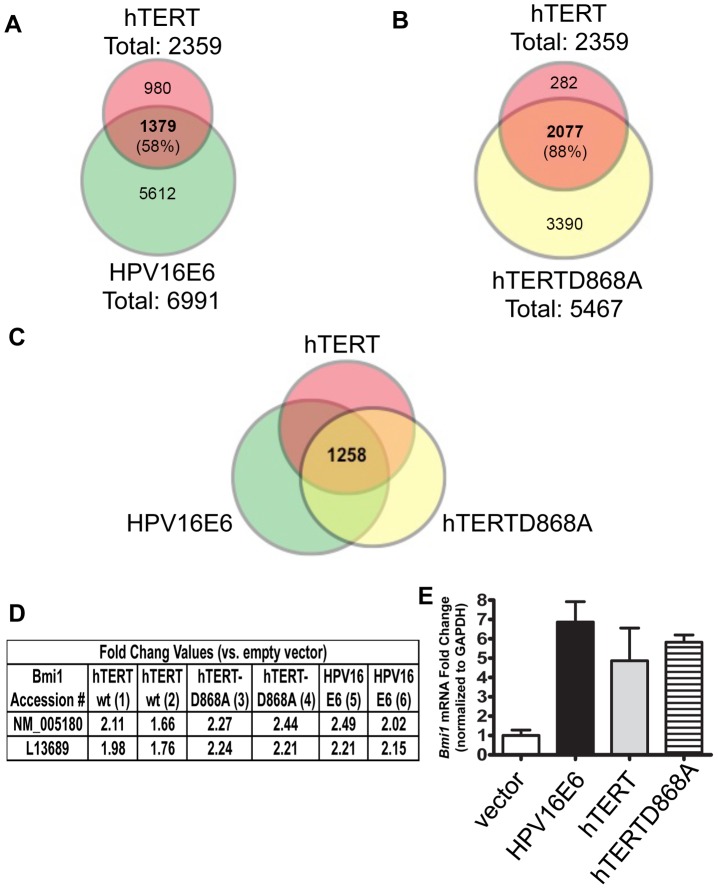
E6, hTERTwt, and hTERT-D868A alter the expression of overlapping gene sets, including chromatin remodeling genes such as Bmi1.Primary HFKs were stably transduced with either E6, hTERTwt, hTERT-D868A or puro babe control vector. Samples were submitted for whole genome expression array analysis (Figure S3). Expression profile changes shown by hTERTwt are compared to expression profile changes in E6 (A) and hTERT-D868A mutant (B). As expected, a significant amount of the expression changes seen in E6 (6991 total changes) were also altered by hTERT wt (1379, representing 20% of the E6 changes). Conversely, more than half of the hTERT changes (58%, 1379 of 2359 changes) were also seen by E6. Interestingly, of the 2359 genes altered by hTERTwt, 2077 of them (88%) were also altered by the hTERTci mutant (fold change >1.33 and p value <0.01). (C) 1258 changes were shared by E6, hTERTwt, and hTERT-D868A, including Bmi1. (D) Numerical fold change values are shown for all arrays as they correspond to two probes, NM_005180 and L13689. These accession numbers represent Bmi1 mRNA sequences that are 99% identical. Quantitative RT-PCR was performed on the E6 and hTERTwt or hTERT-D868A (E) with gene-specific primers for Bmi1 to validate the array results, normalized to GAPDH. n = 3. Bars represent mean ± SD.